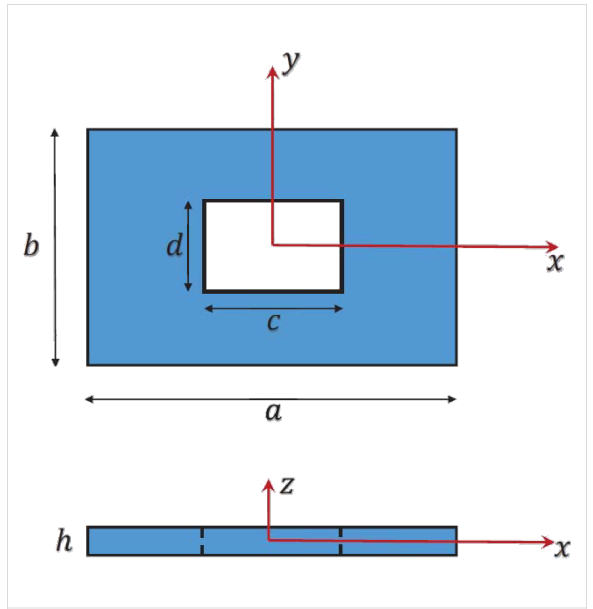
Figure 1: A schematic of the geometric features of the plate along with the assigned coordinate